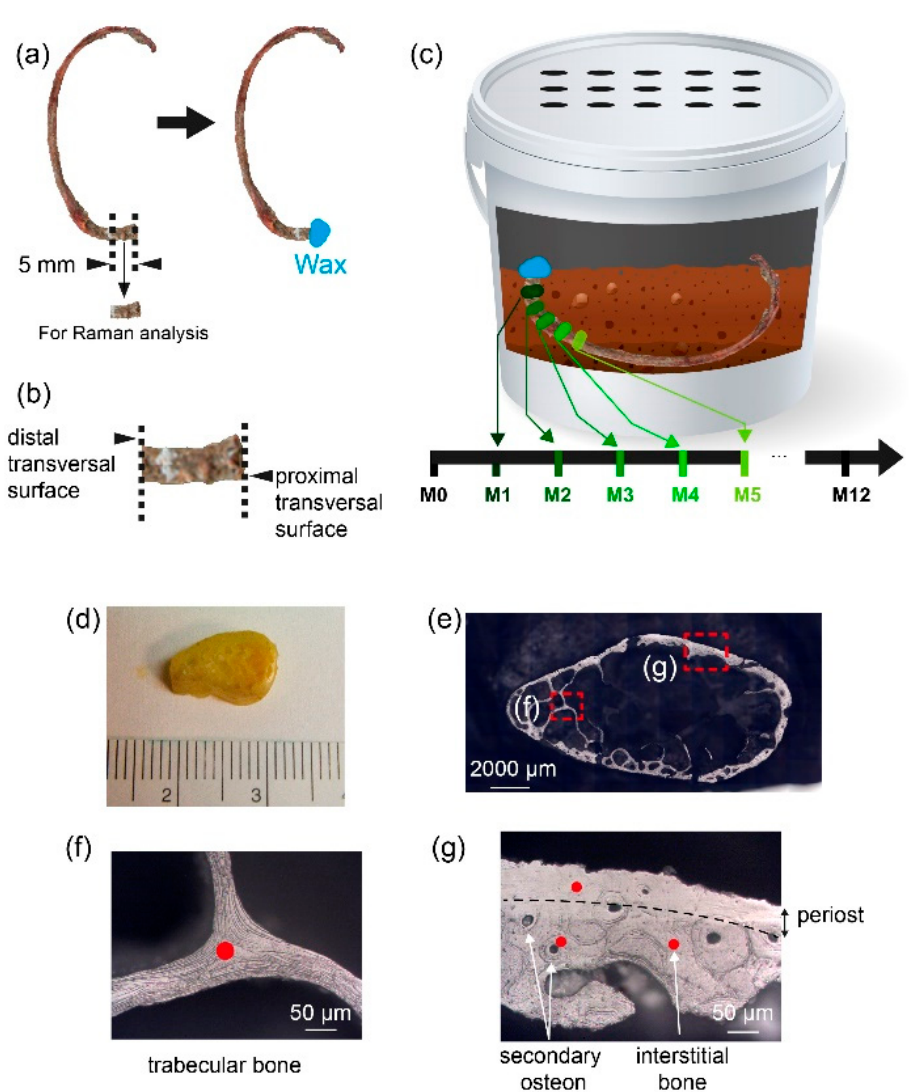
Figure 1. Description of the protocol of preparation of the rib for Raman analysis. This protocol is repeated 12 times for 12 months for each rib. ( a ) Left panel: schema of a rib before the cutting procedure at M0. The dashed lines represent the limits of the cut. Right panel: rib after cutting procedure. The wax protects the outer proximal surface. ( b ) Zoom on the sample analysed by Raman microspectroscopy. The proximal transversal surface is protected by the wax. The distal transversal surface is not in contact with the wax and is analysed by Raman microspectroscopy. ( c ) Representation of a plastic bin with soil and one rib. One rib is represented to simplify the representation. It shows that a new 5 mm thick section of the same rib is cut each month and analysed by Raman. To do the cutting procedure, the rib is exhumed and reburied each month. ( d ) Piece of rib after the cutting procedure. The visible side corresponds to the distal transversal surface. ( e ) Optical image of the piece of rib under Raman microscope. The visible side corresponds to the distal transversal surface analysed by Raman microspectroscopy. The insets ( f , g ) show examples of each type of bone and the area analysed by Raman microspectroscopy. ( f ) Example of trabecular bone analysed. ( g ) Example of cortical bone showing periost, secondary osteon and interstitial bone analysed. The red dot represents the localization of the analysis. For each type of bone, 10 spectra were acquired at 10 different